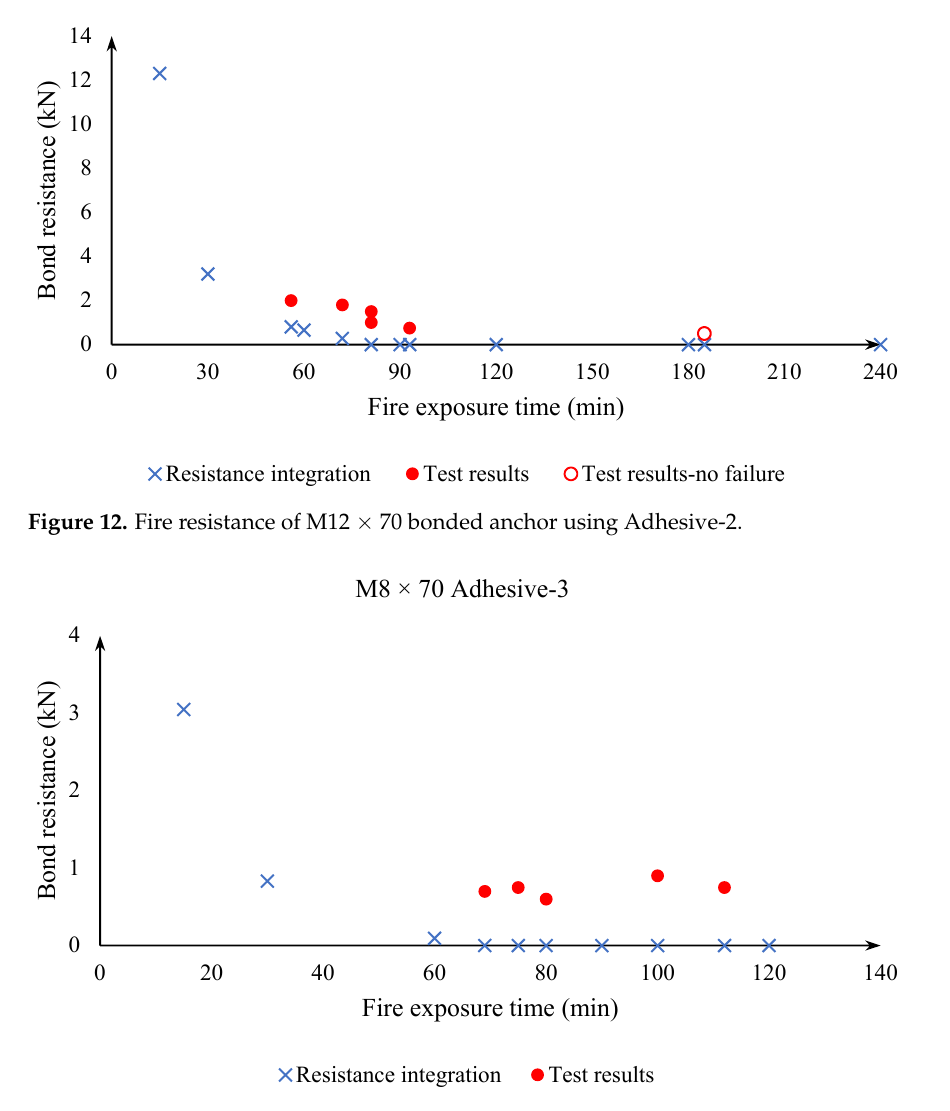
Figure 13. Fire resistance of M8 × 70 bonded anchor using Adhesive-3.